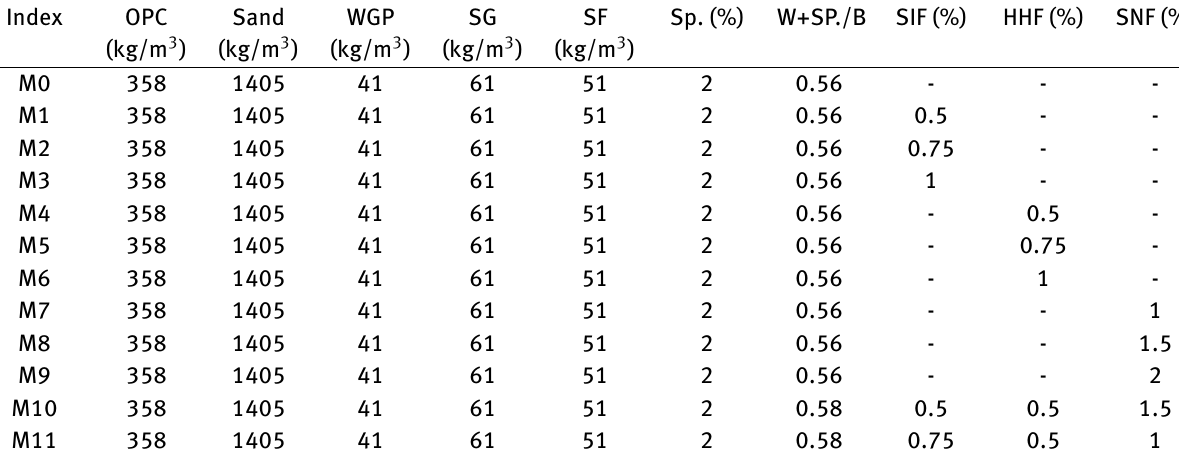
Table 6: Mix proportions of reinforced green mortar used